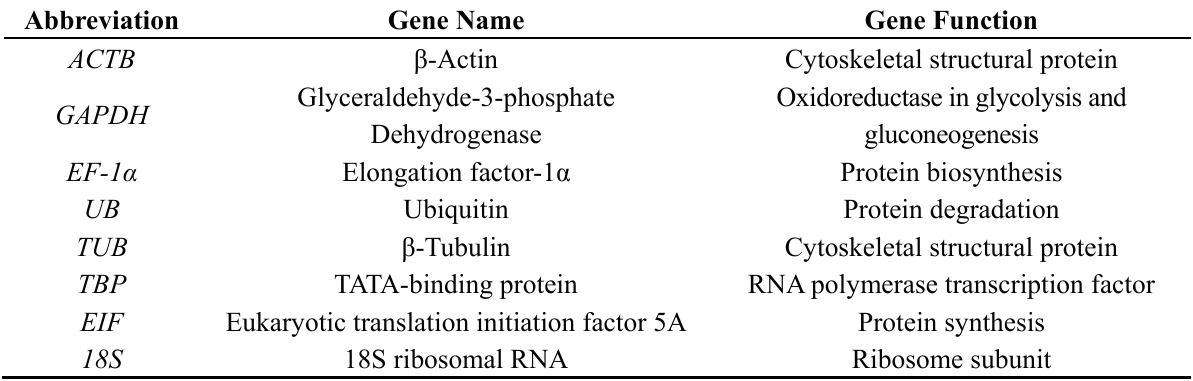
Table 4. Candidate reference genes investigated in this